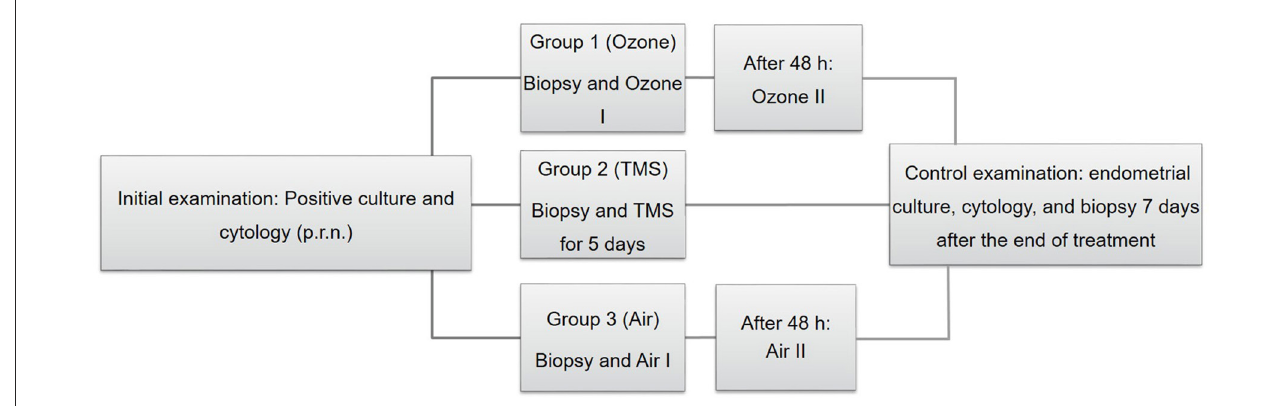
FIGURE1 Schematic depiction of the experimental design, including the initial examination (on the left) treatment of groups [Group 1–3; (center) ] and the control examination (on the right) . TMS,